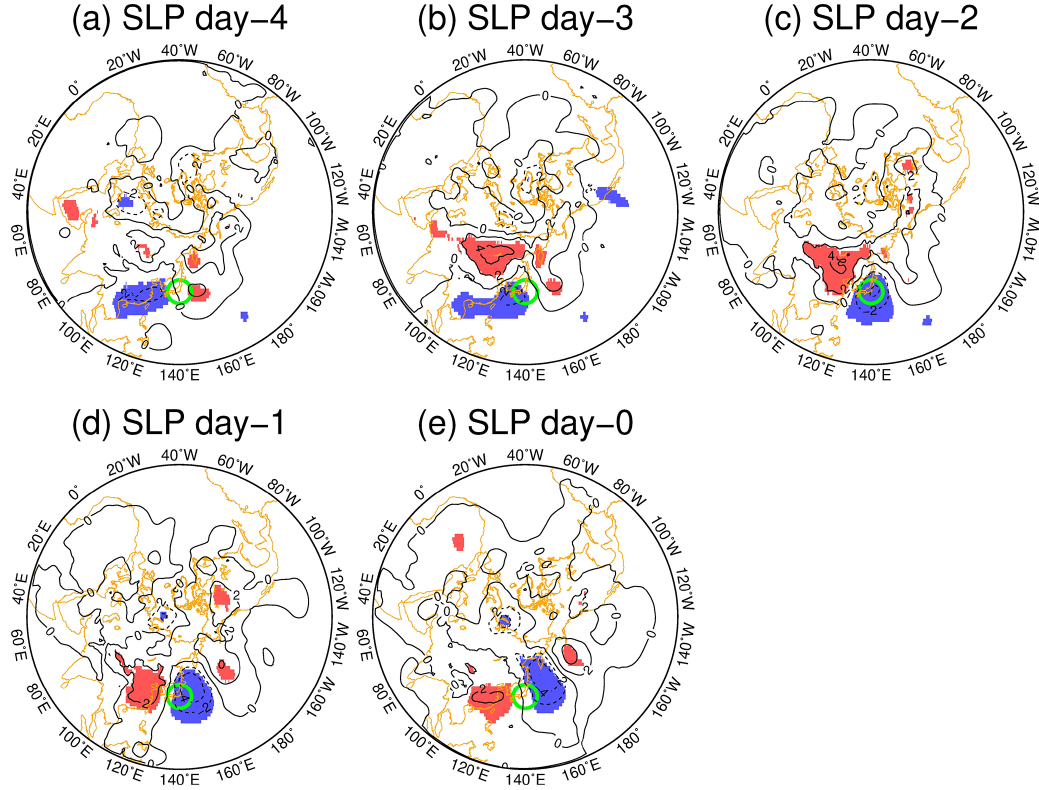
Figure 6. Composite daily mean sea level pressure (SLP; hPa) from day 4 to day 0 for 1968/69–1979/80. The contour interval is 2hPa, and the red and blue shading denotes positive and negative anomalies significant at the 95% confidence level, respectively, based on a two-tailed Student’s t test. A green circle indicates the position of